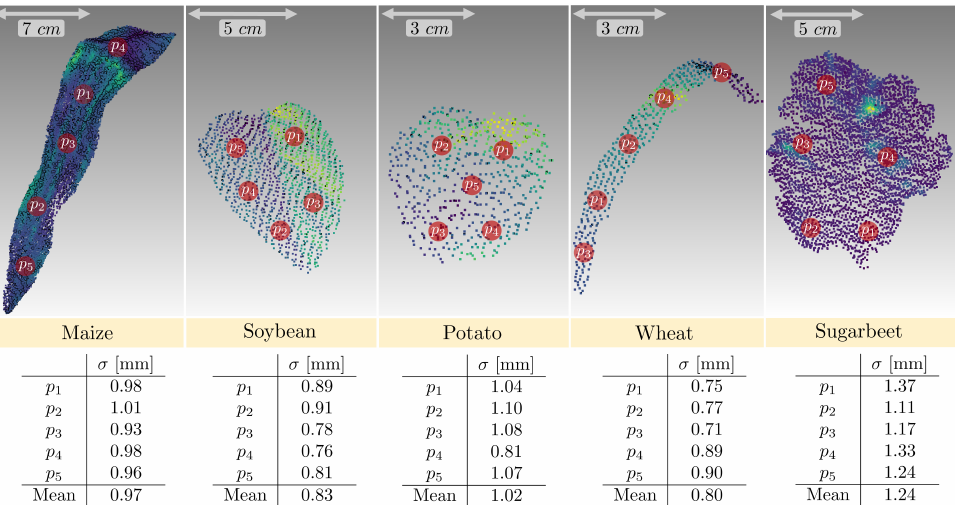
Figure 8. Leaf point clouds of maize, soybean, potato, wheat, and sugar beet colorized by laser intensity used for point precision and spatial resolution analysis. The numbers correspond to the core points selected for precision evaluation. The tables summarize the estimated standard deviations of the local point-to-plane distances derived at the core